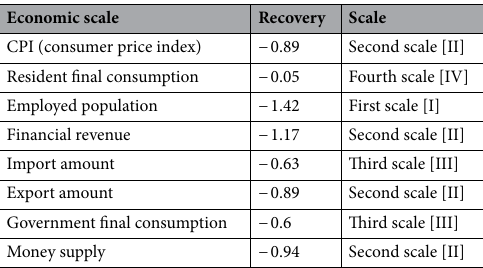
Table 3. Forecast of individual economic performance